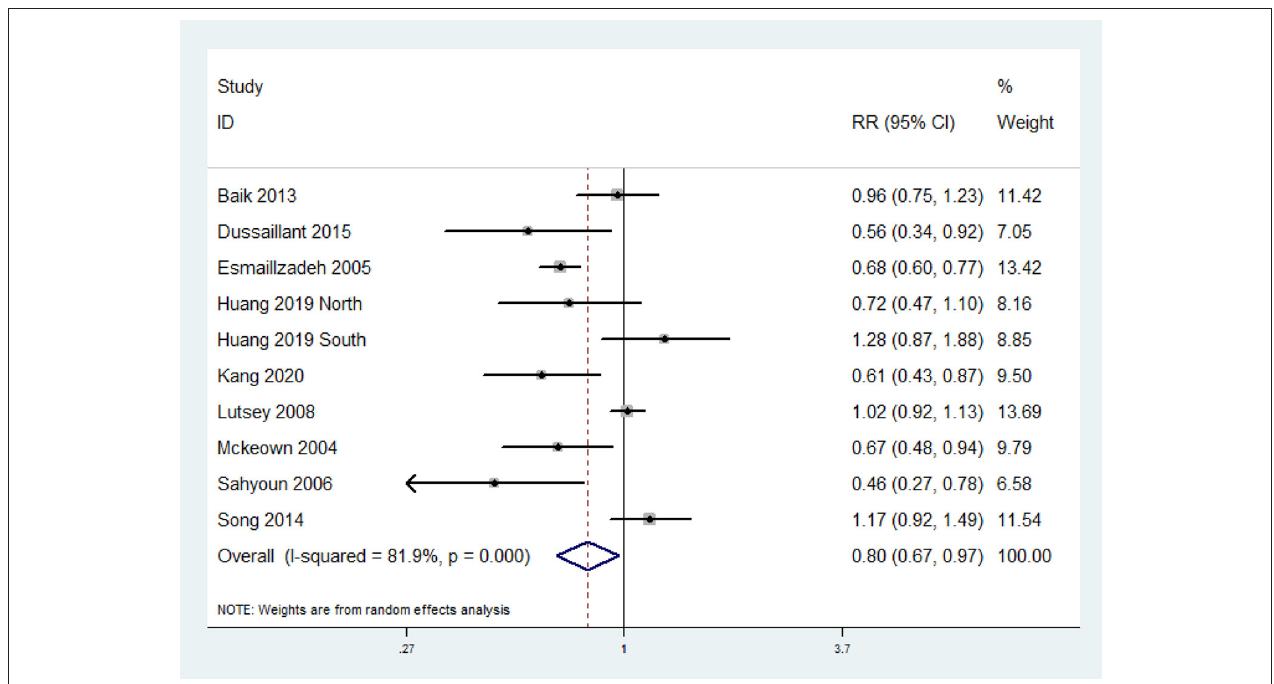
FIGURE 2 | Forest plot of meta-analysis: Overall multi-variable adjusted RR of MetS for the highest vs. the lowest category of whole grain consumption.